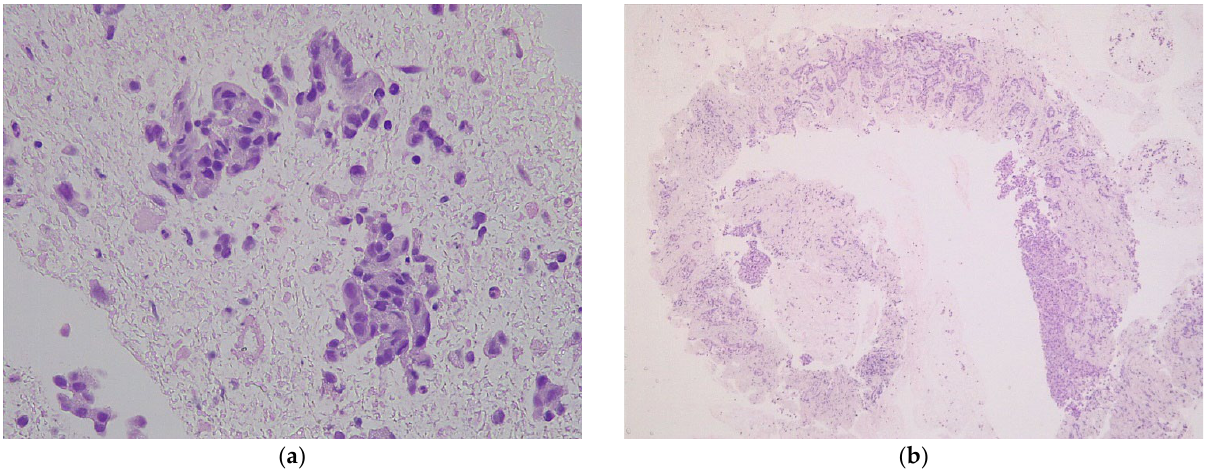
Figure 2. Microscopic aspects of endoscopic ultrasound specimen from an intrahepatic cholangio- carcinoma (hematoxylin- eosin): ( a ) FNA specimen ( × 40) with free - floating pleomorphic biliary epithelium without stromal support, rare neutrophils, and red blood cells; ( b ) FNB specimen ( × 5) with neoplastic biliary epithelium infiltrating cores of liver parenchyma.